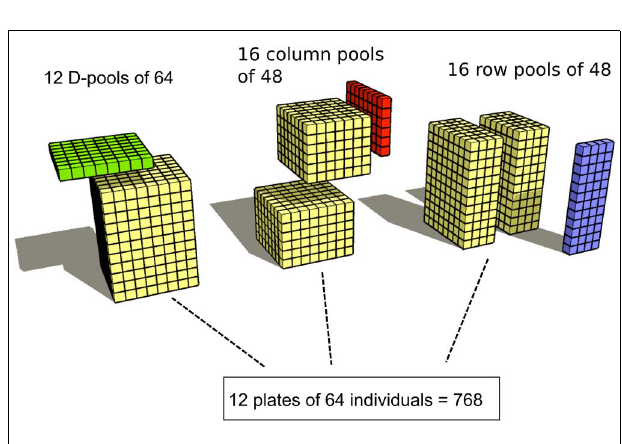
FIGURE 2 |The three-dimensional pooling strategy used byTsai etal. (2011, reprinted with permission).